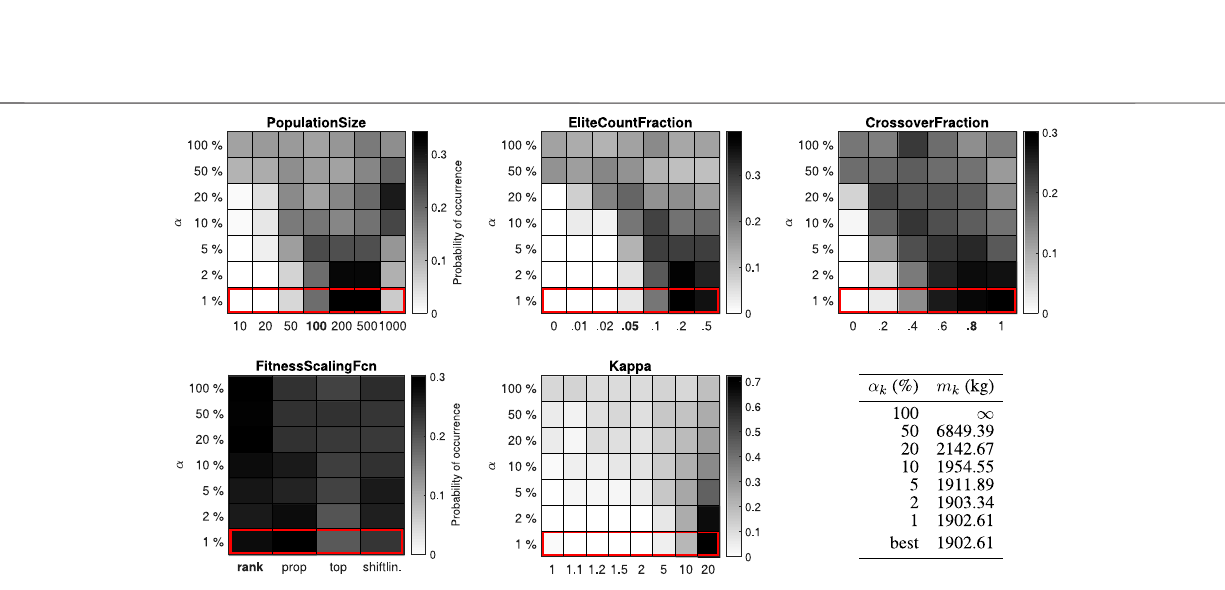
Frontiers in Built Environment |